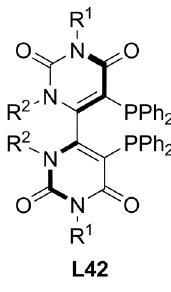
Figure 19. Pd-catalysed allylic alkylation of rac - 1a using ZnEt